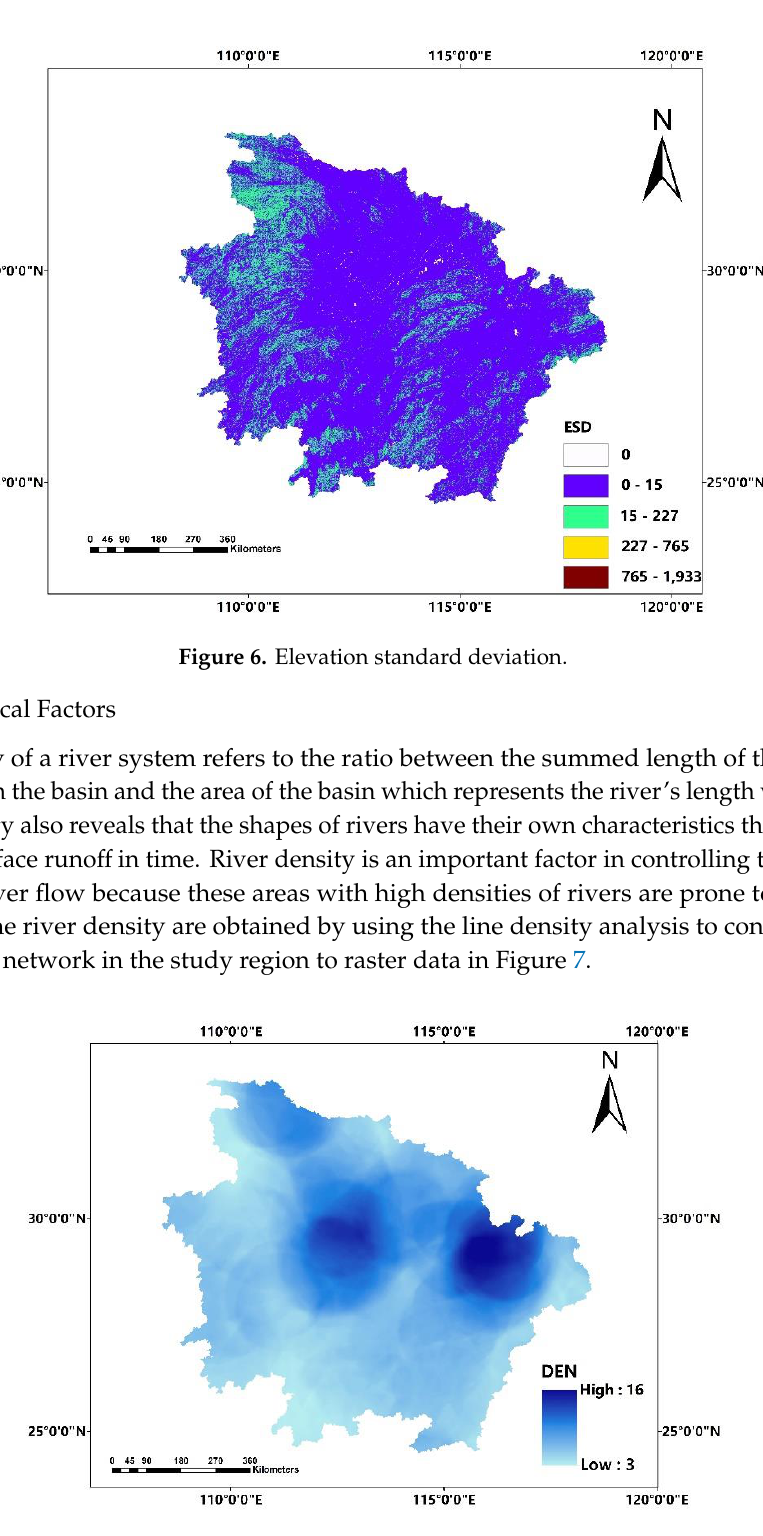
Figure 7. River Density.